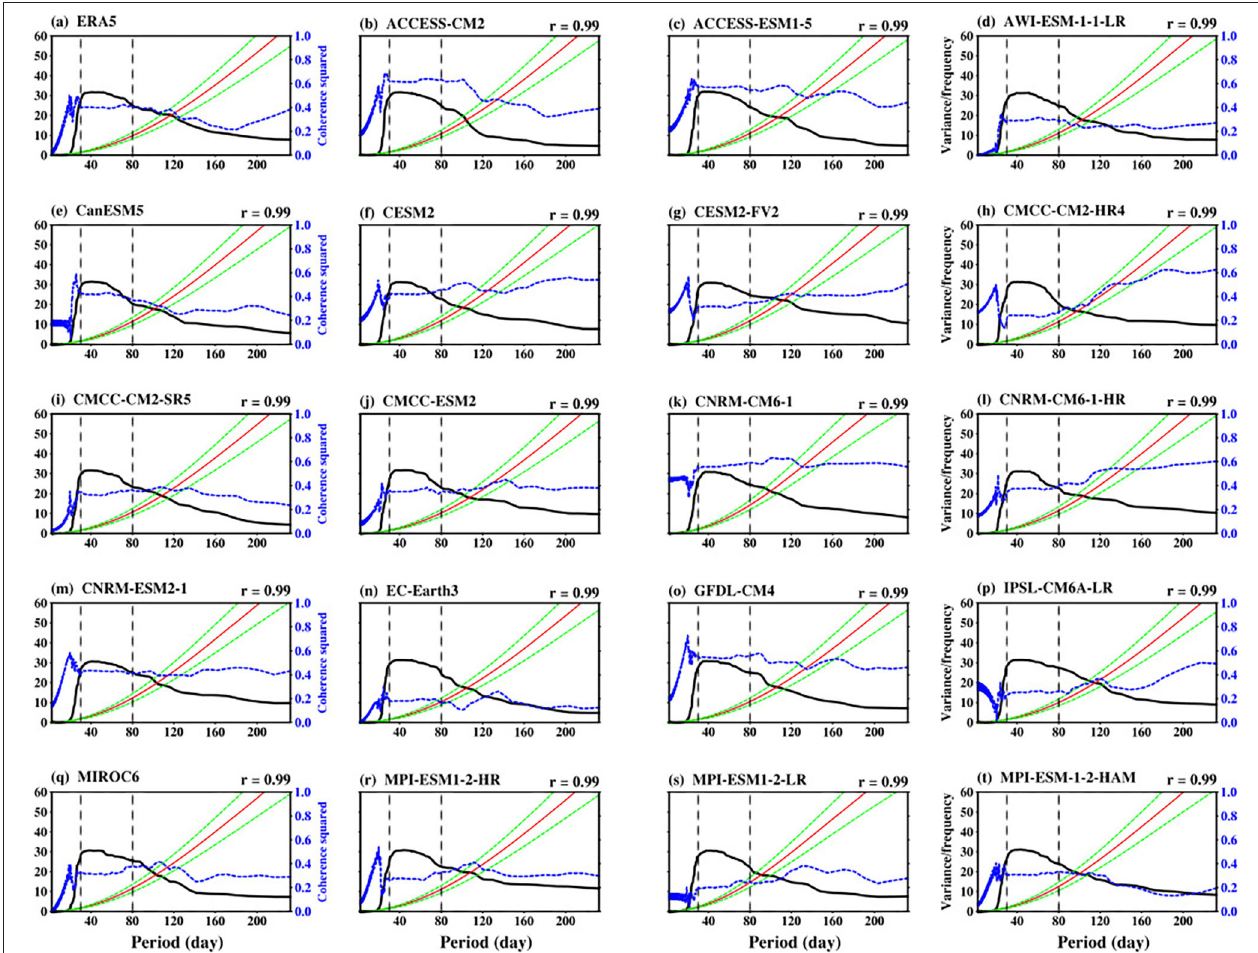
FIGURE 7 | ERA5 (a) and CMIP6 models (b–t) power spectrum (solid black line) and coherence squared (dashed blue line) of the filtered PC1 (EOF1) obtained by projecting the 30–60-day filtered CEOFs onto 30–60-day daily anomaly data. The red noise spectrum (solid red line) and the 5 and 95% confidence limits (dashed green lines) are also